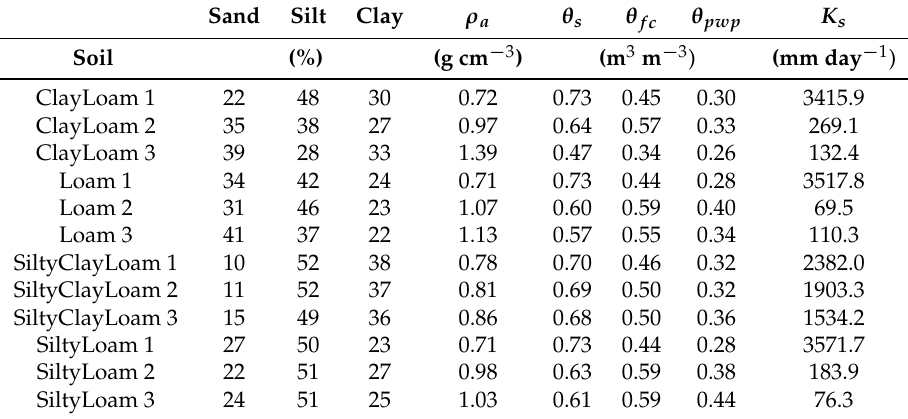
Table 3. Bulk density ( ρ a ), saturation ( θ s ), field capacity ( θ fc ), permanent wilt water content ( θ pwp ), and saturated hydraulic conductivity ( K s ) [38], as representative of the Central Valley of Chile [29,33,39]. Sand Silt Clay ρ a θ s θ fc θ pwp K s Soil (%) (g cm − 3 ) (m 3 m − 3 ) (mm day − 1